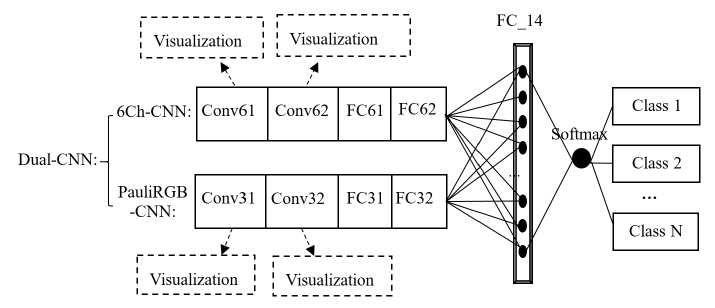
Figure 11. The location of the visualization process.